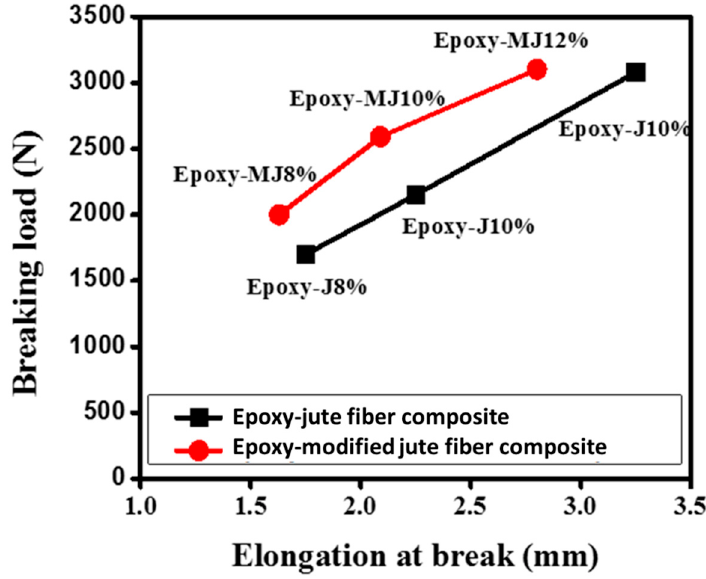
Figure 6. Elongation at break of the jute fiber composites with di ff erent fiber Figure 6 . Elongation at break of the jute fiber composites with different fiber contents.